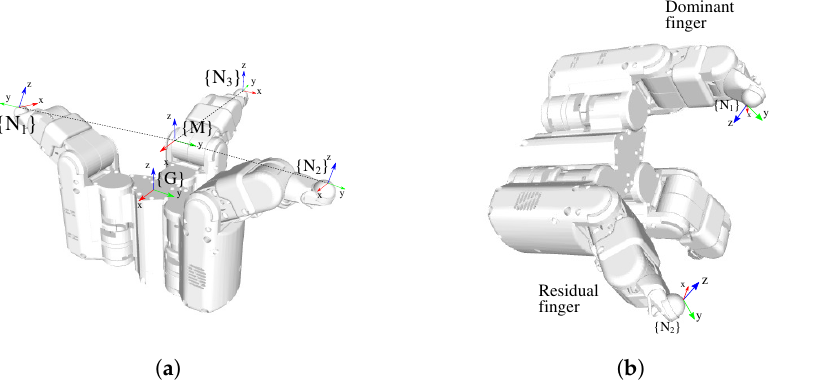
Figure 8. The IGS finger configuration for the two grasp strategies employing the RAMCIP hand. ( a ) the finger configuration for grasping the “pill box” from the table. Frames { G } , { M } and { N i } are shown; ( b ) the finger configuration for grasping the “pill box” from the high shelf.